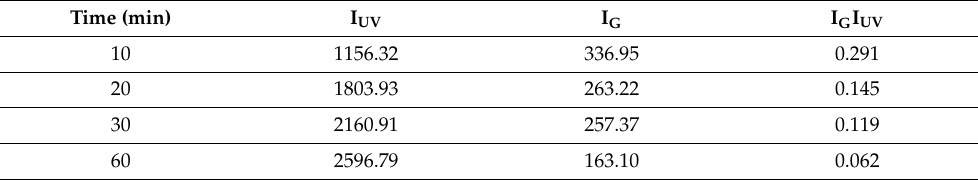
Figure 6. Effect of synthesis time on the PL spectra of ZnO NFAs. Table 3. Defect comparisons of ZnO NFAs under different synthesis